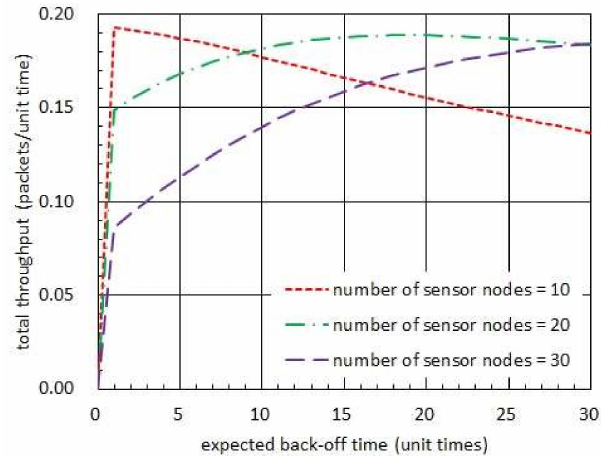
Figure 7. Total throughput with respect to expected back-o ff time when harvest time is longer than transmission time.